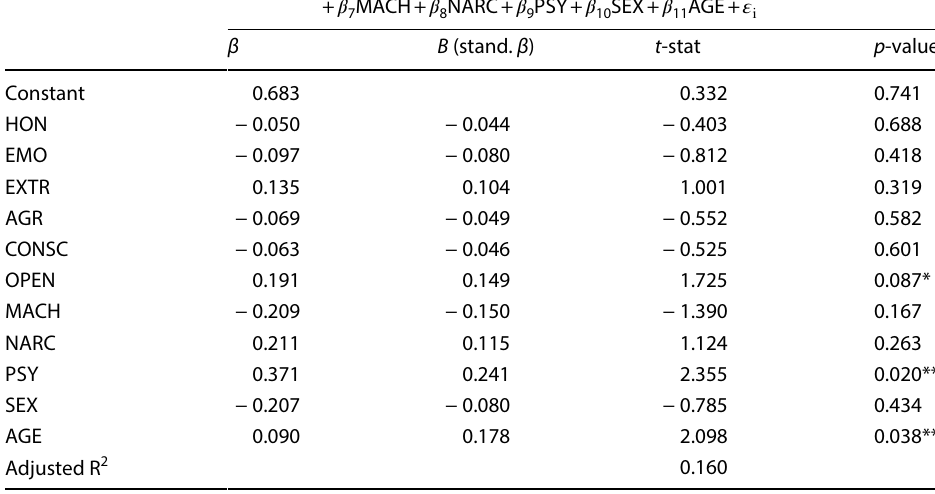
Table 5 Results of the regression analysis for the impact of personality traits on career starters’ attitudes towards frequent job-quitting behaviour